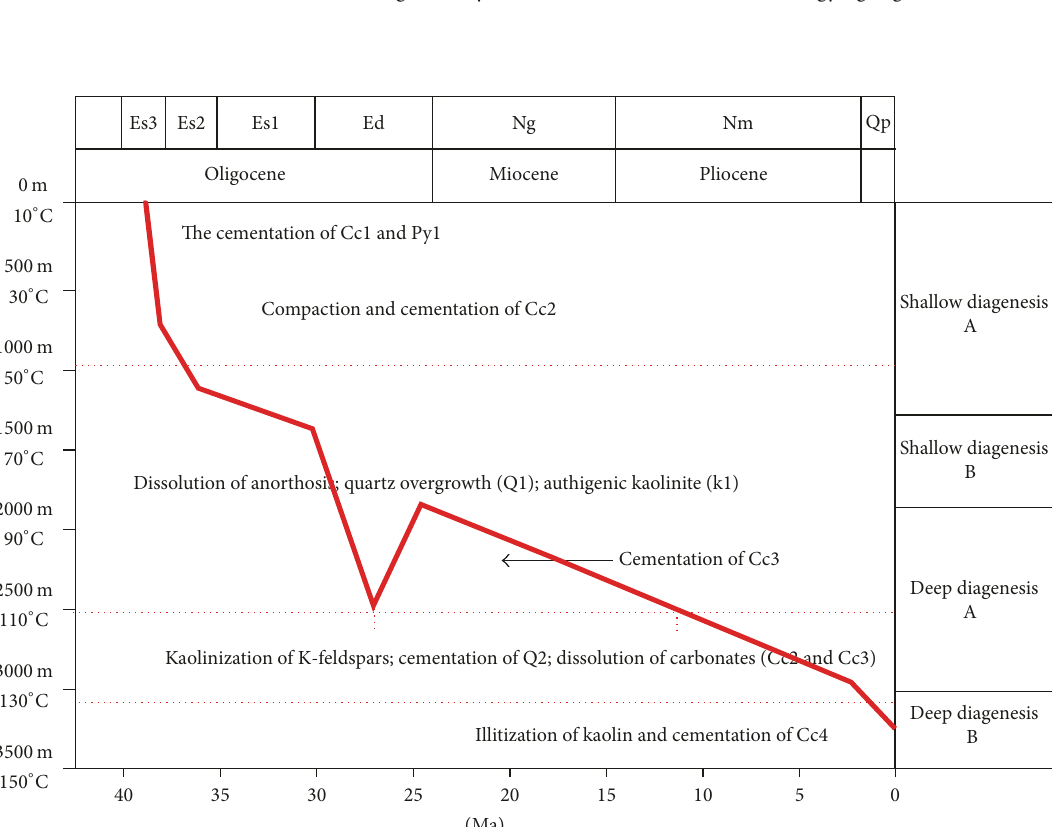
Figure 15: The content changes of clay minerals in Es sandstones from Dongying Sag.